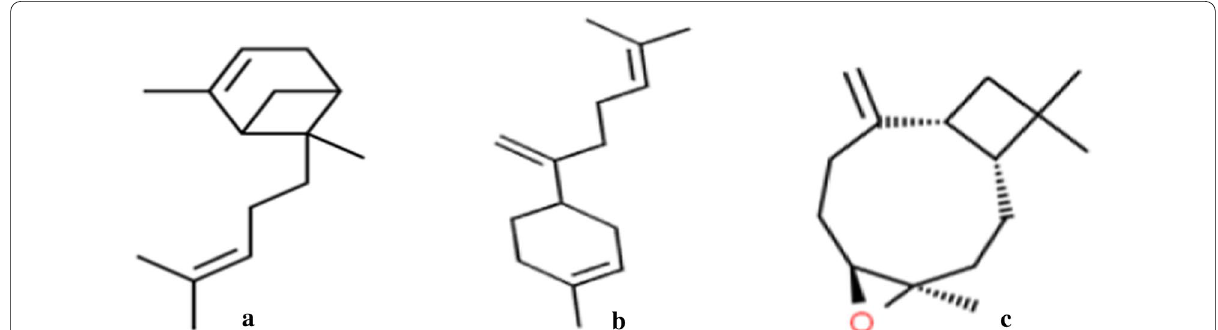
Fig. 4 Structures of a α-bergamotene, b β-bisabolene, c Caryophyllene oxide